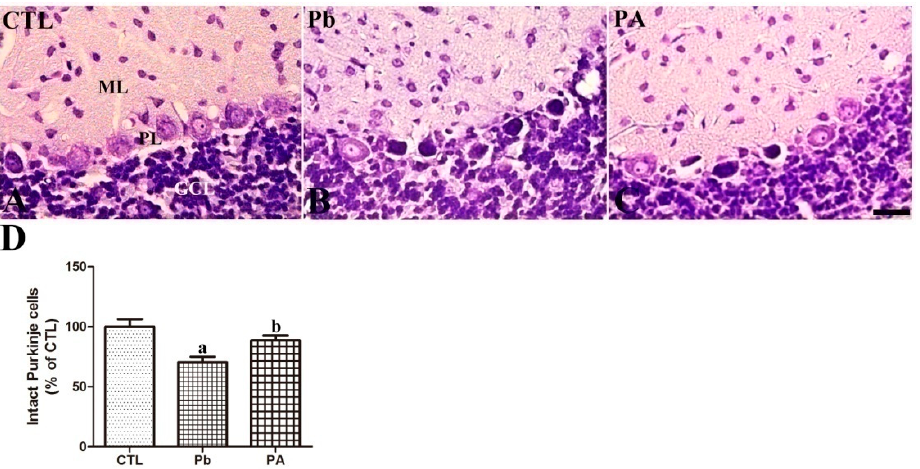
Figure 2. Nissl staining of cerebellum ( A – C ) of offspring from CTL, Pb, and PA groups. GCL, granule cell layer; ML, molecular layer; PL, Purkinje cell layer. Bar = 25 µ m. ( D ) The numbers of intact Purkinje cells in the cerebellum are expressed as percentages of the value in the CTL group. The number of intact Purkinje cells in three sections per offspring in non-overlapping fields, 12 rats were included in each group ( n = 12 offspring per group; a p < 0.05, indicating a significant difference compared with the control group, b p < 0.05, indicating a significant difference compared with the Pb group). The bars indicate the means ± standard errors of the mean.